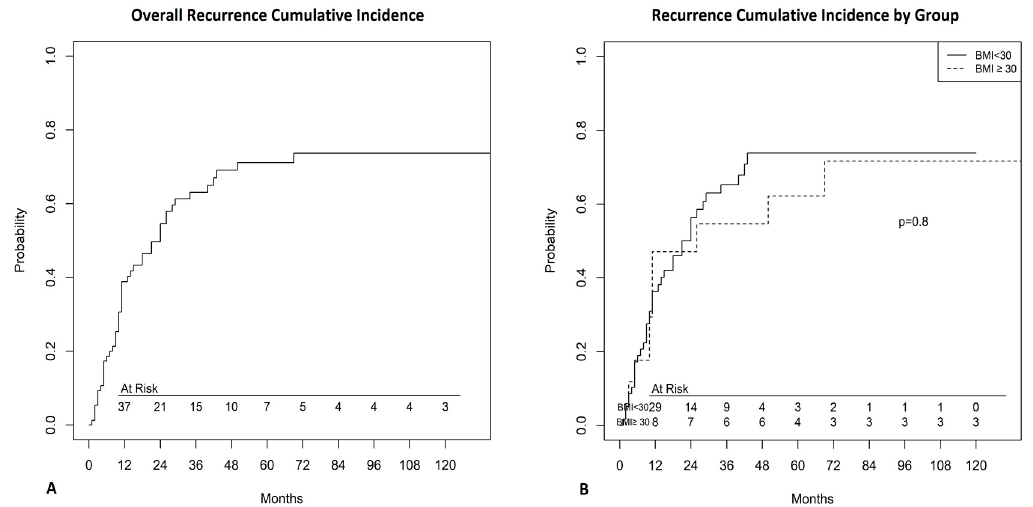
Figure 2. ( A ) Cumulative incidence of recurrence for the whole population. ( B ) Cumulative